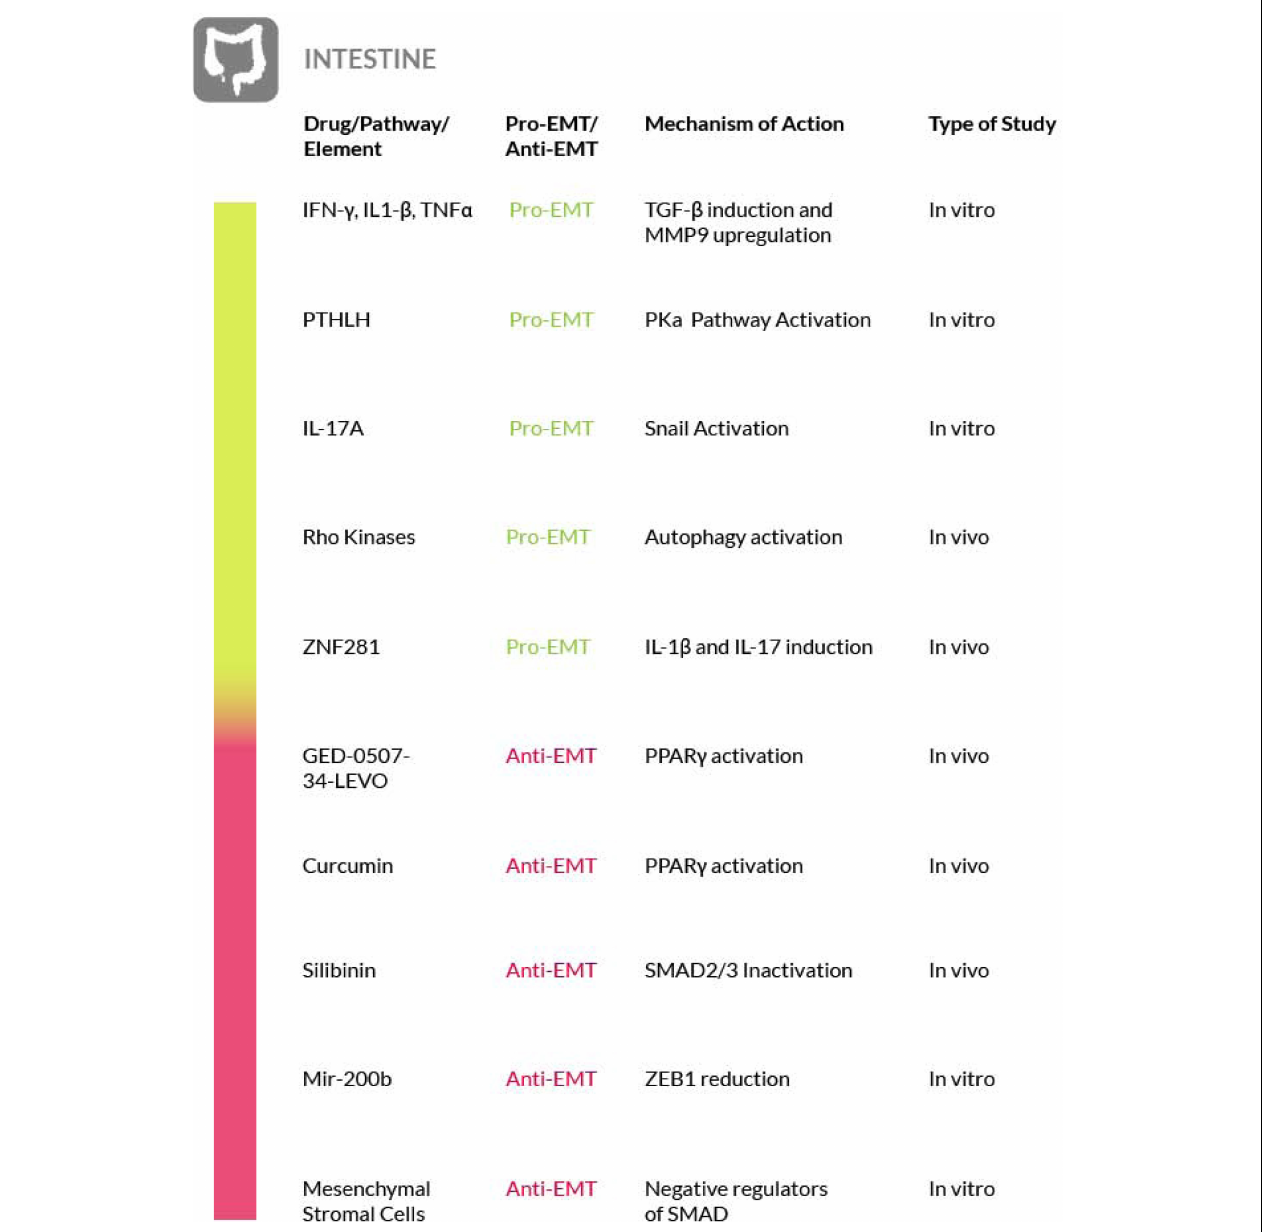
FIGURE 7 | Most relevant molecular mechanisms and possible drugs for the treatment of EMT in intestinal fibrosis.